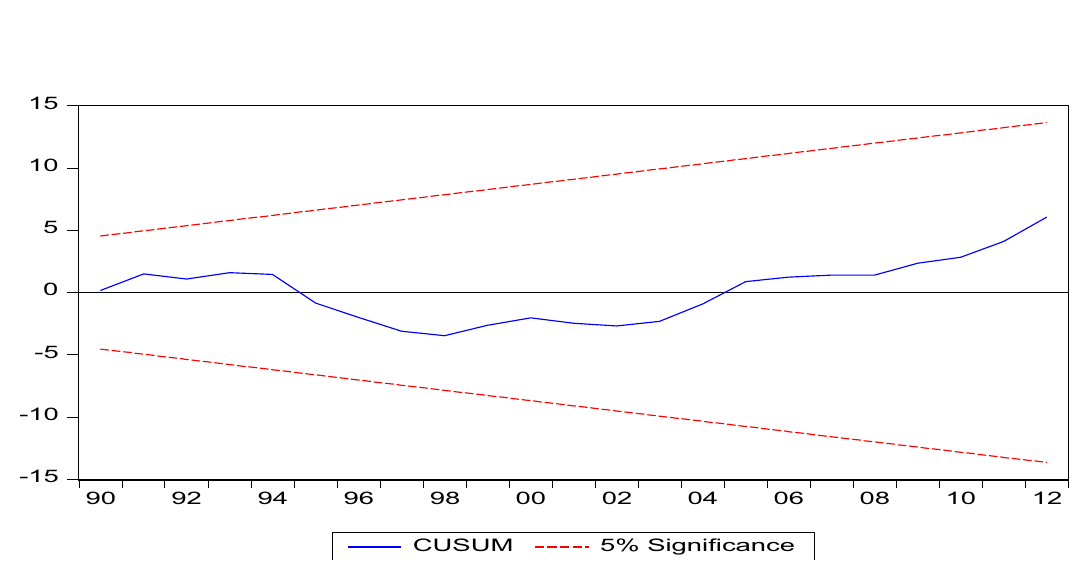
Figure A2: Stability test for model